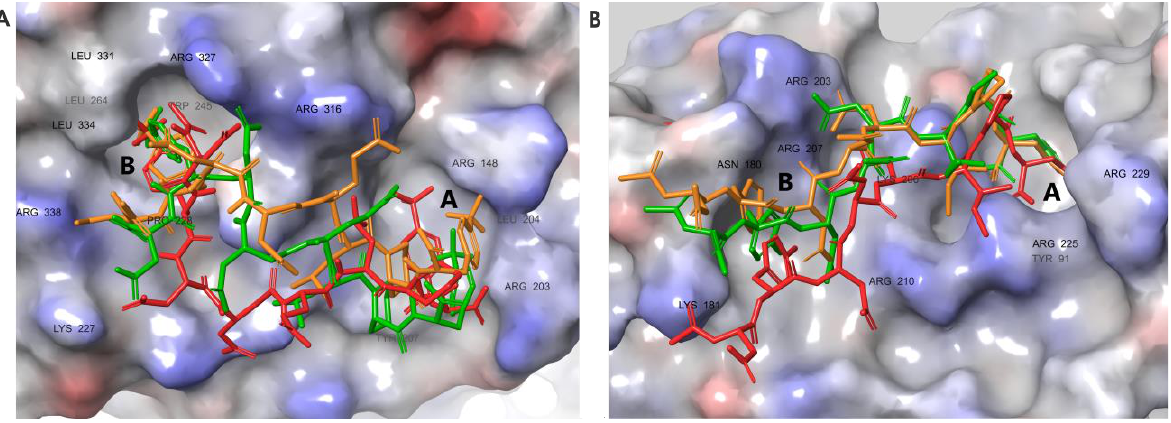
Figure 8. Representative structures for the complexes ExoI–E1-sSSB-Ct ( A ) and RecO–R2-sSSB-Ct ( B ). Binding modes were clustered using the affinity propagation method based on the backbone RMSD values of the ligands, and the central structures of the clusters are displayed.